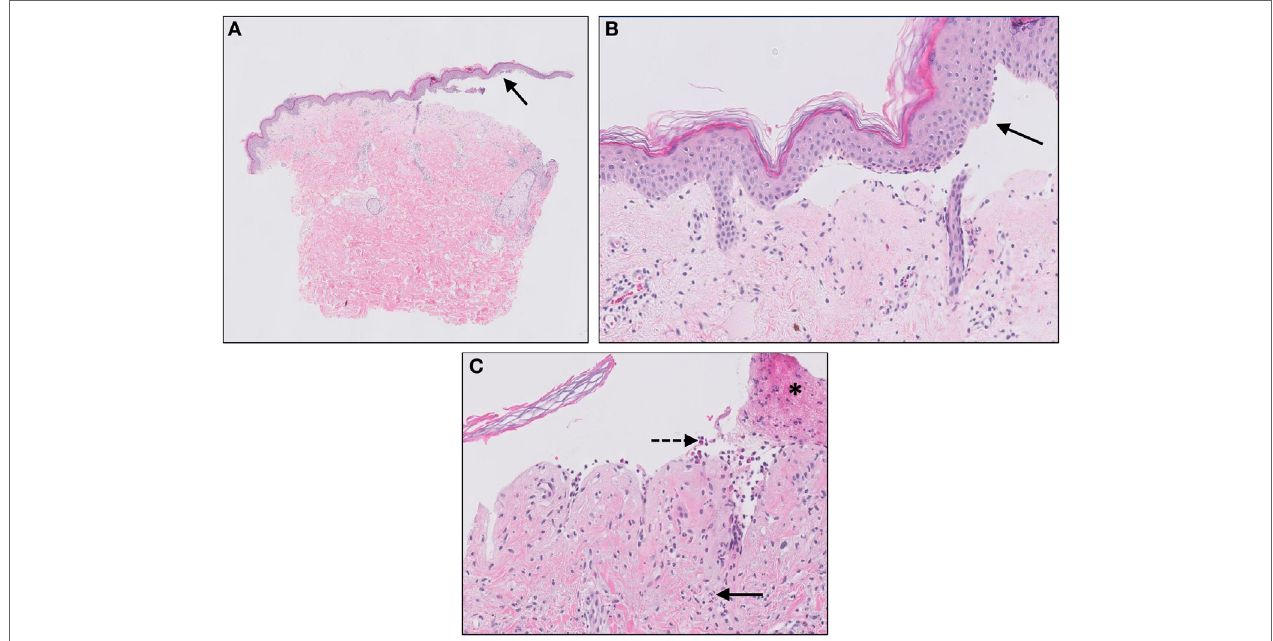
FigURe 6 | Bullous pemphigoid. Subepidermal blistering [solid arrows in (A,B) ] and influx of inflammatory cells including eosinophils and neutrophils in the dermis [solid arrow (C) ] and blister cavity [dashed arrows (C) ]. In (C) also deposition of fibrin is noted